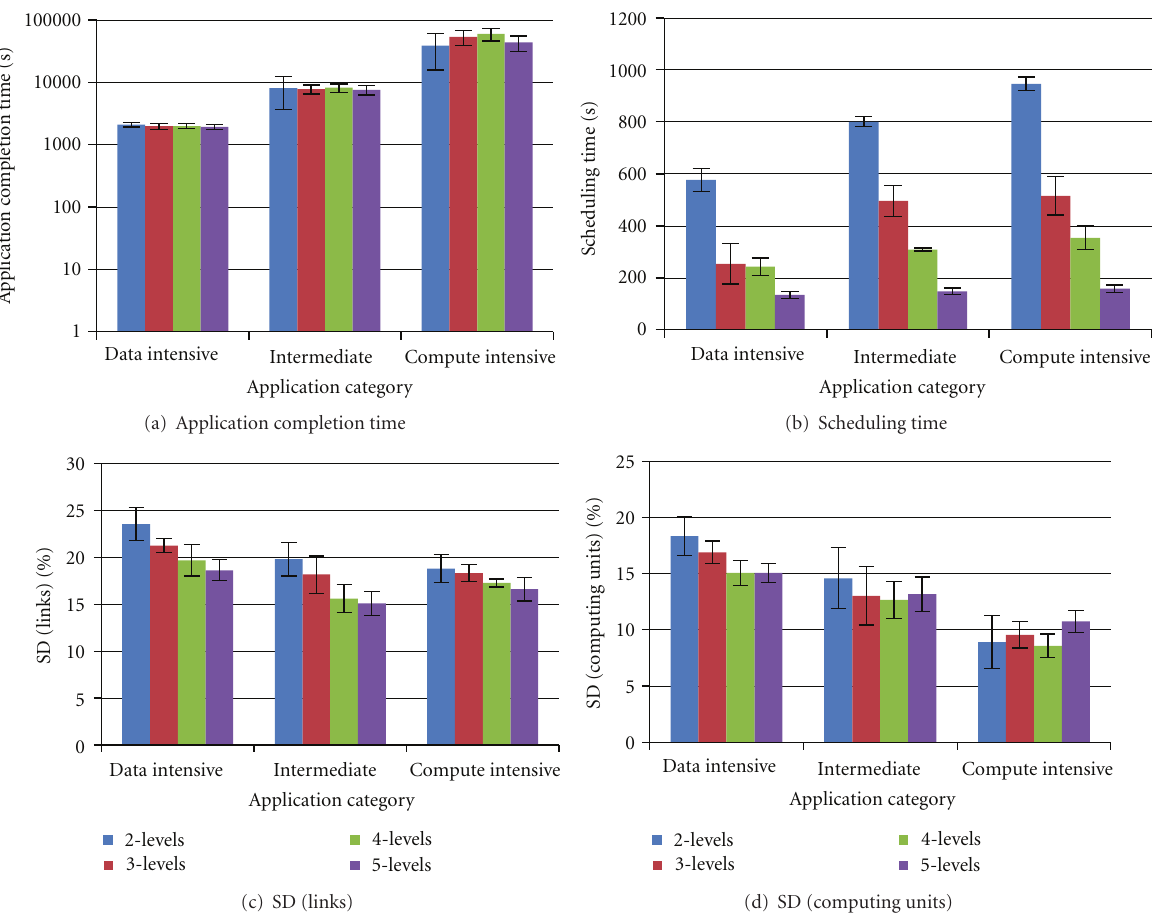
Figure 3: The E ff ect of depth of hierarchy for di ff erent application